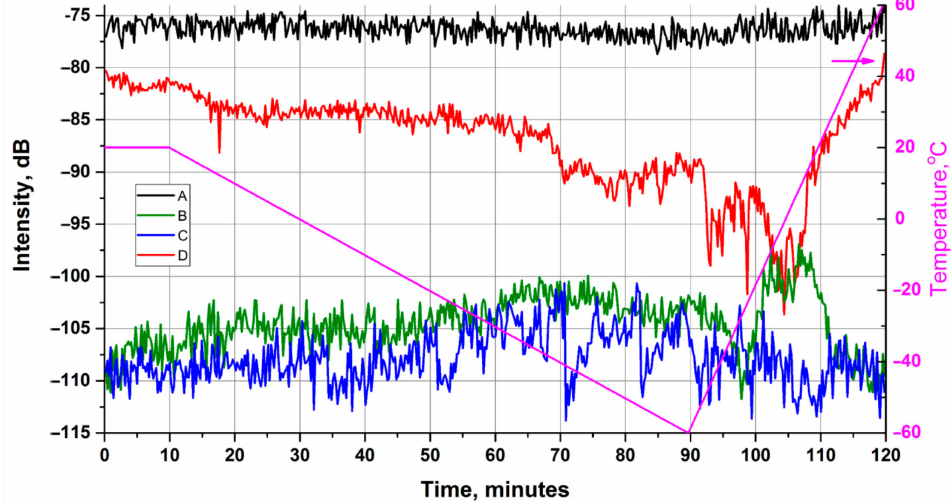
Figure 10. Temperature dynamics of the intensity in the IOM different areas. Locations A,B,C,D are presented at Figure 9.